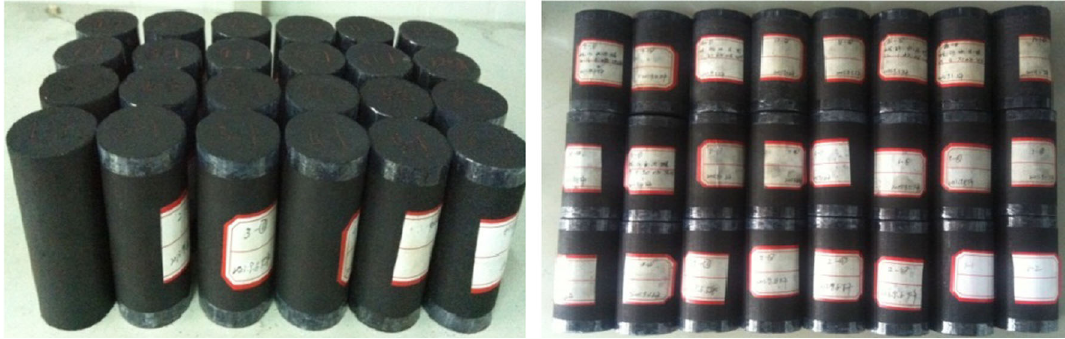
theoretical calculation. UCS of similar material specimen